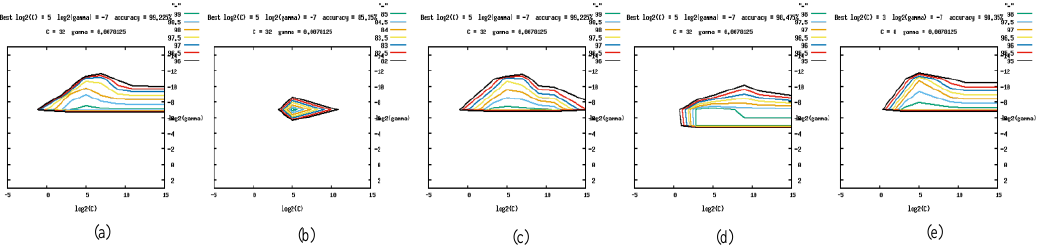
Figure 5. Parameter optimization figures under different feature fusion operation in the LivDet 2015